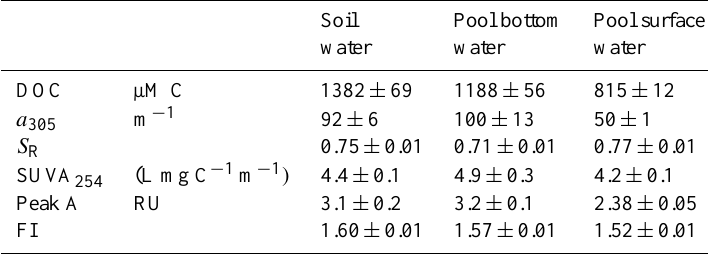
Table 3. DOM in soil waters compared to pool water in Imnavait Creek under stratified conditions.